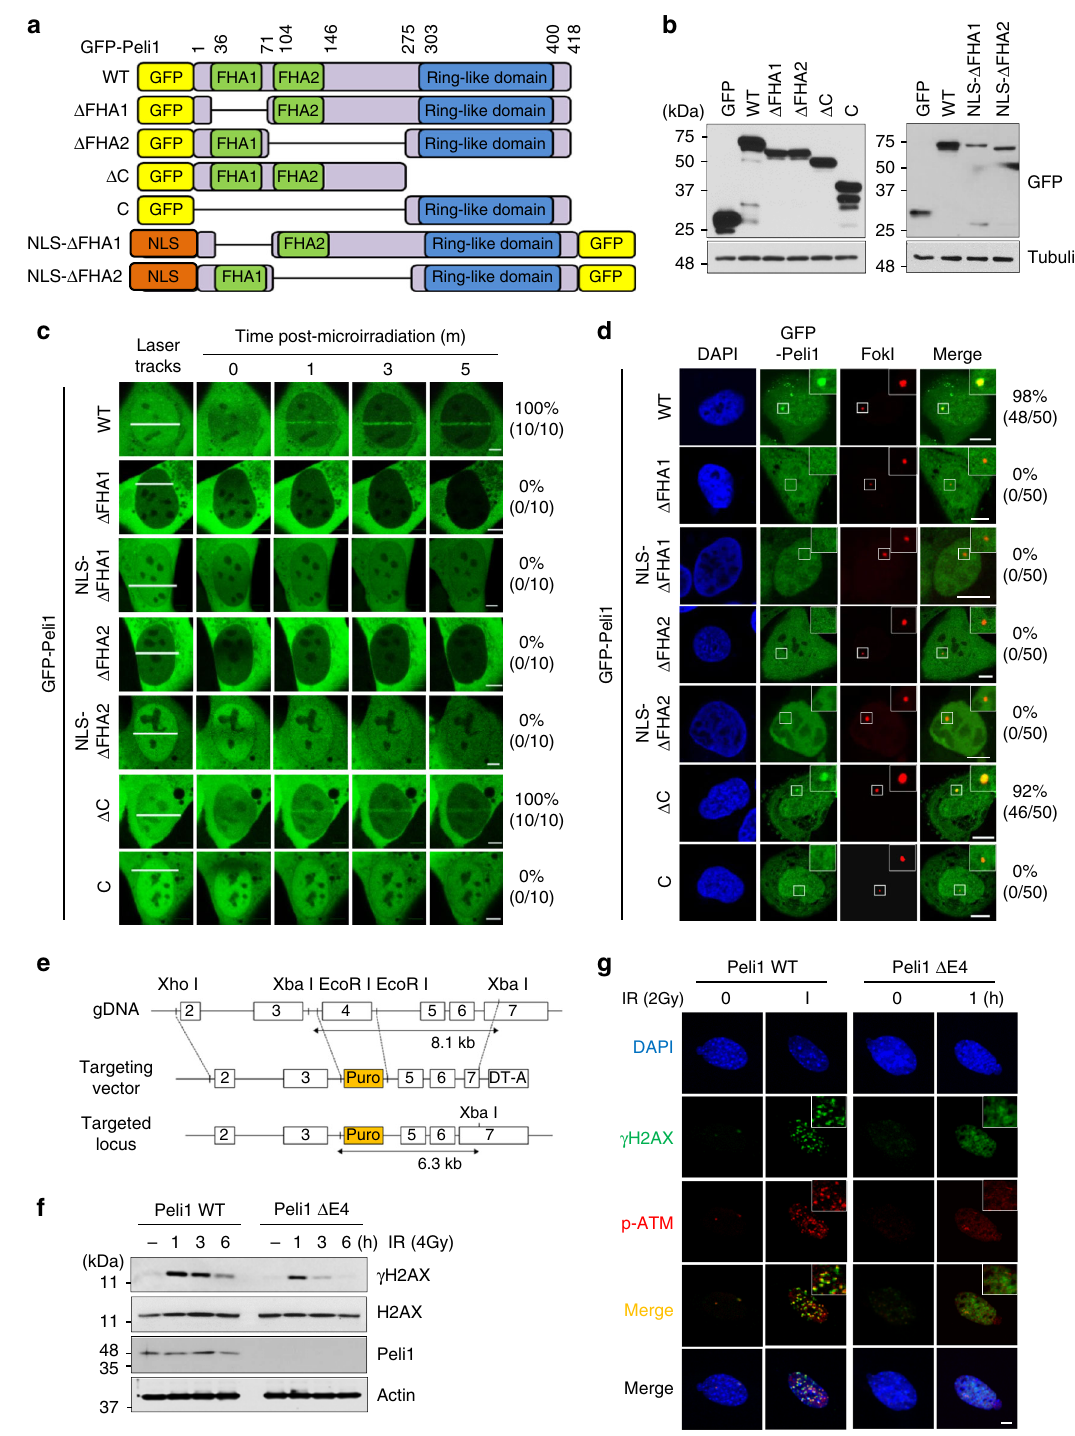
Fig. 2 Deletion of Peli1 FHA domains impaired DNA damage response. a Diagrams of Peli1 WT, deletion, and NLS-fused deletion mutants. b 293T cells were transfected with plasmids encoding GFP-Peli1 WT, each of deletion and NLS-fused mutants. At 48 h post transfection, cells were collected and cell lysates were analyzed by immunoblotting with anti-GFP and anti-tubulin antibodies. c U2OS cells were transfected with GFP-Peli1 WT or each mutant and treated with BrdU (10 μ M) for 30 h followed by laser micro-irradiation. Scale bar, 10 μ M. d mCherry-LacI-FokI and GFP-fused Peli1 WT or mutants were cotransfected into U2OS-DSB reporter cells (U2OS 2 – 6 – 3). At 48 h, cells were fi xed and visualized by confocal microscopy. Scale bars, 10 μ m. e Targeting strategy to generate PELI1 mutant mice in which coding for exon 4 was replaced with a puromycin cassette gene, resulting in Peli1 E4 truncated mice. f Peli1 WT and E4 truncated MEFs were treated with IR (4 Gy) as indicated. Cells were collected and then subjected to immunoblotting with Peli1, γ H2AX, H2AX, and actin antibodies. g Peli1 WT and E4 truncated MEFs were treated with IR (2 Gy) and allowed to recover for 1 h before processing for γ H2AX and phospho-ATM (p-Ser1981) immunostaining. Scale bars, 10 μ